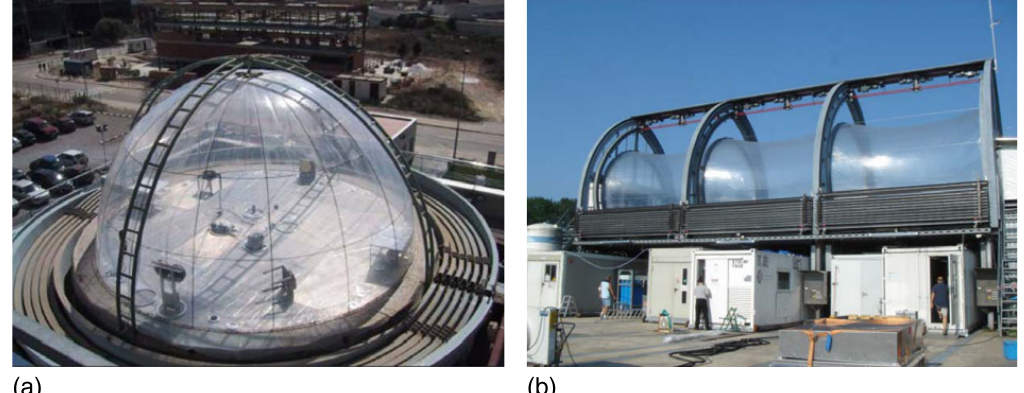
Fig. 2. (a) The EUPHORE chamber in Valencia. (b) The SAPHIR chamber in Julich.